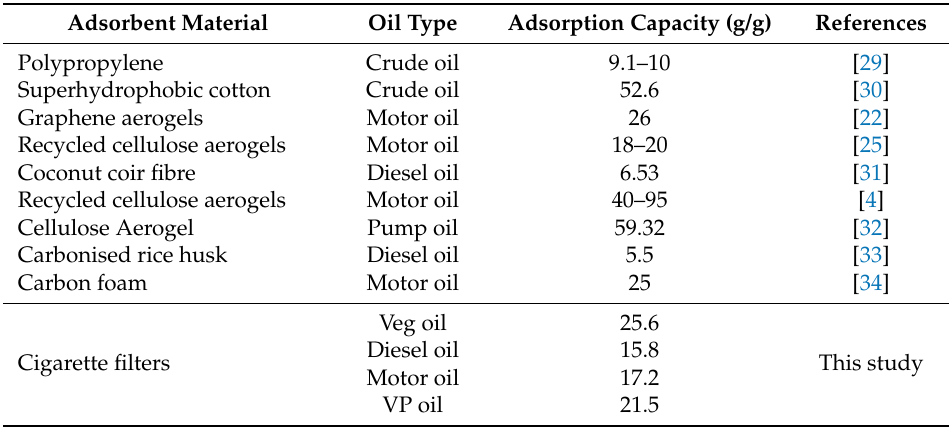
Table 1. Adsorption capacity of various fabricated sorbent materials.